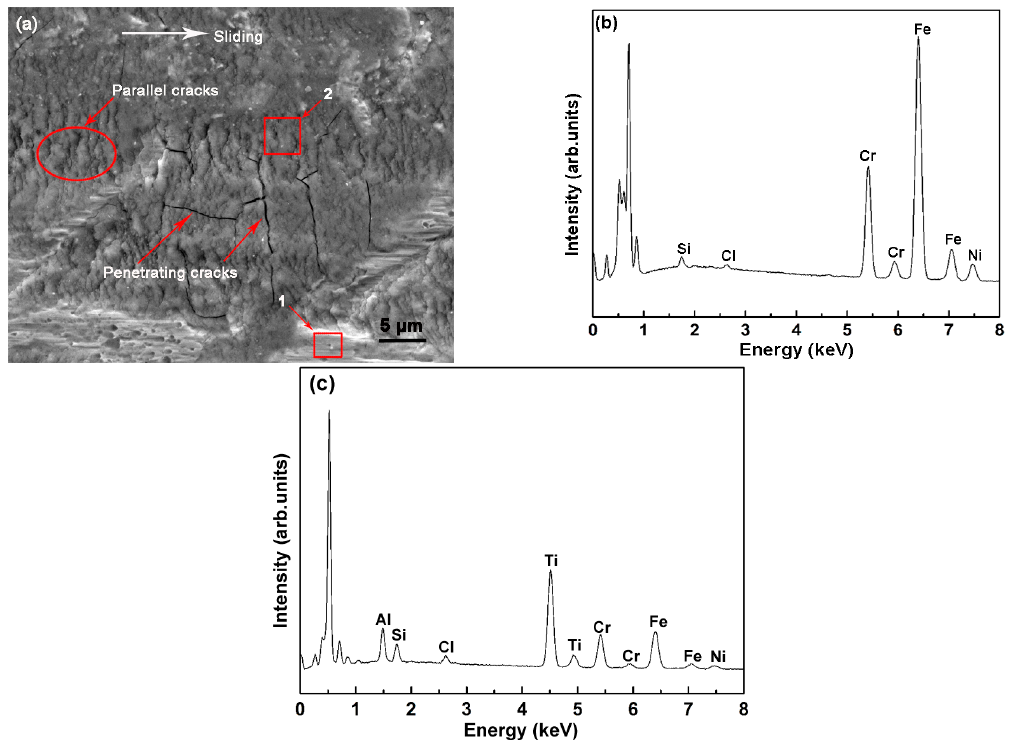
Figure 12. ( a ) High resolution SEM image of the tribocorrosion plough; ( b ) EDS analysis of zone 1; ( c ) EDS analysis of zone 2.